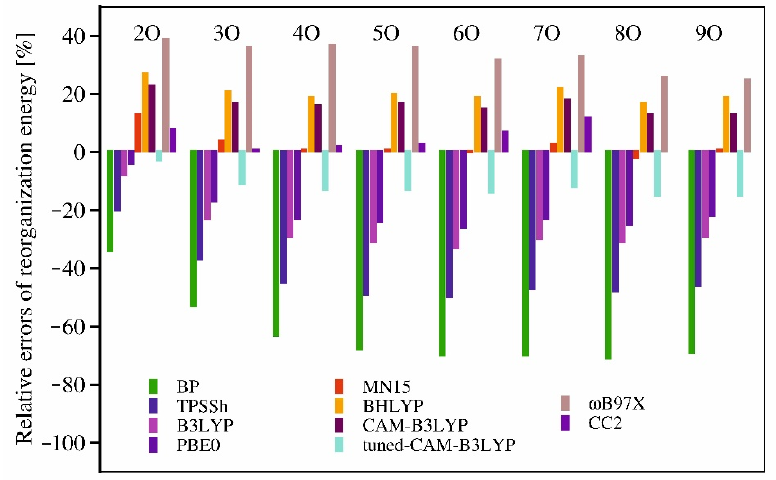
Figure 5. Relative errors of the calculated reorganization energies for the studied